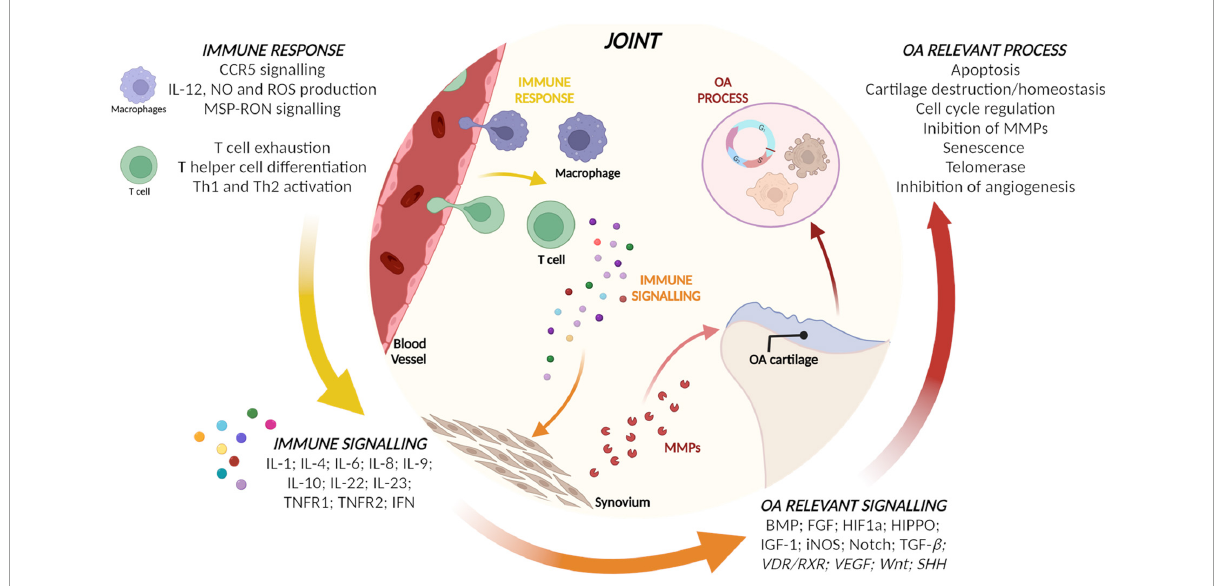
FIGURE3 Relevant pathways for immune response and osteoarthritis (OA) identified by ingenuity pathway analysis (IPA) using the target genes of micro RNAs (miRNAs) of the three